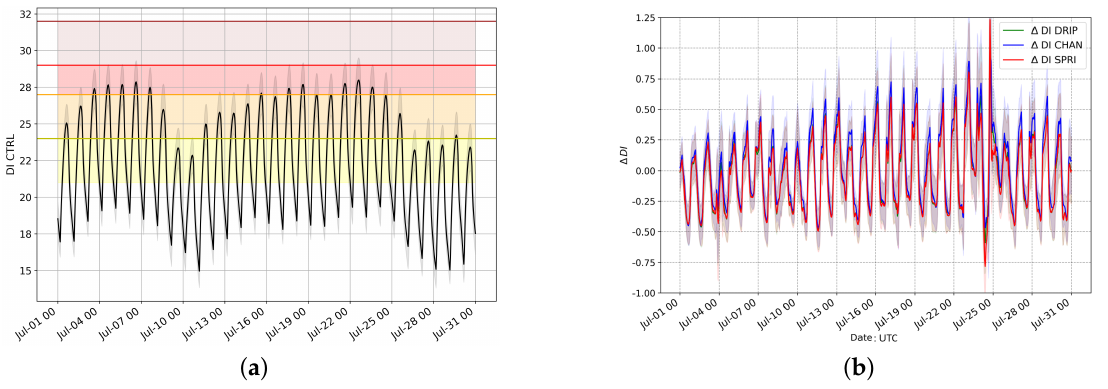
Figure 11. Discomfort index (DI) averaged for the irrigated area (spatial standard deviation as shading)